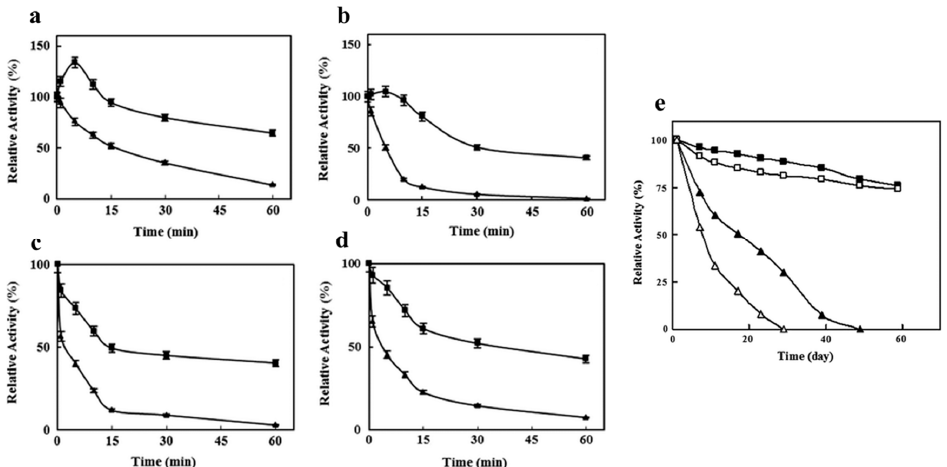
Figure 11. Stability of free papain (triangles) and papain immobilized on gold nanorods (squares) in mixed buffer. ( a ) Irreversible thermoinactivation at 80 °C. ( b ) Irreversible thermoinactivation at 90 °C. ( c ) Enzyme stability at pH 3.0. ( d ) Enzyme stability at pH 12.0. Native and linked papain were